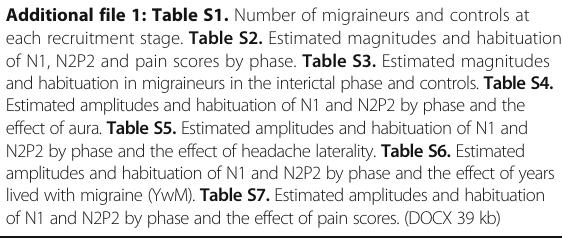
Additional file 1: Table S1. Number of migraineurs and controls at each recruitment stage. Table S2. Estimated magnitudes and habituation of N1, N2P2 and pain scores by phase. Table S3. Estimated magnitudes and habituation in migraineurs in the interictal phase and controls. Table S4. Estimated amplitudes and habituation of N1 and N2P2 by phase and the effect of aura. Table S5. Estimated amplitudes and habituation of N1 and N2P2 by phase and the effect of headache laterality. Table S6. Estimated amplitudes and habituation of N1 and N2P2 by phase and the effect of years lived with migraine (YwM). Table S7. Estimated amplitudes and habituation of N1 and N2P2 by phase and the effect of pain scores. (DOCX 39